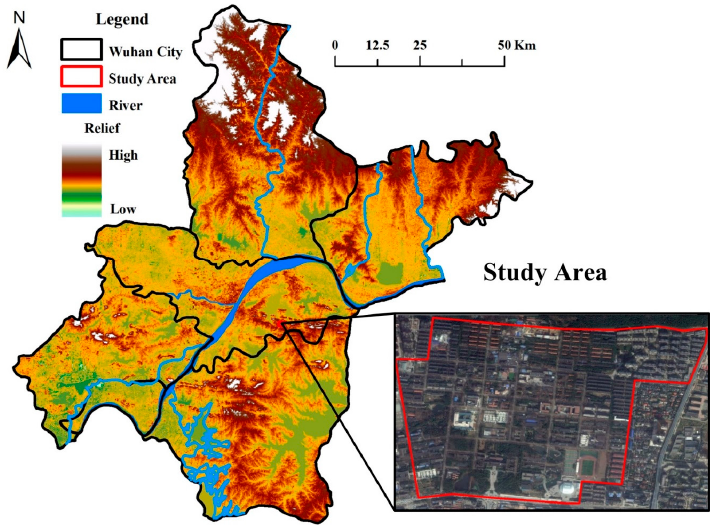
Figure 7. Study area: main campus of Huazhong University of Science and Technology (HUST), Wuhan, China.